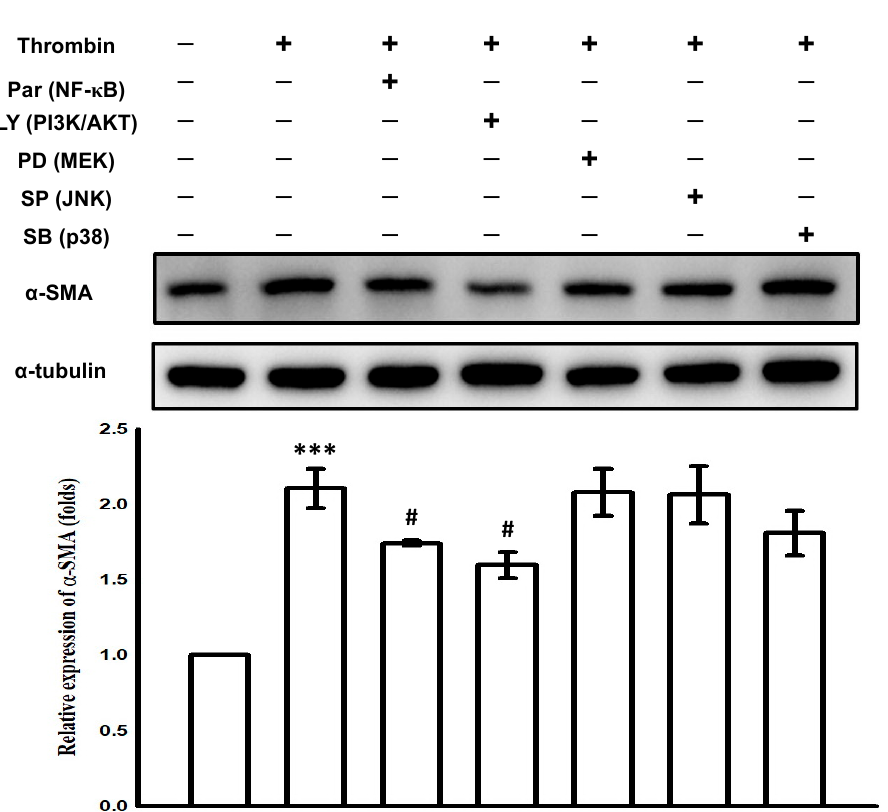
Figure 4. Thrombin induced mmT in CBB-injured mice and human PMCs possibly through PAR-1, PI3K / AKT and NF-B signaling pathways. C57 / B6 mice were treated with saline, CBB, CBB plus